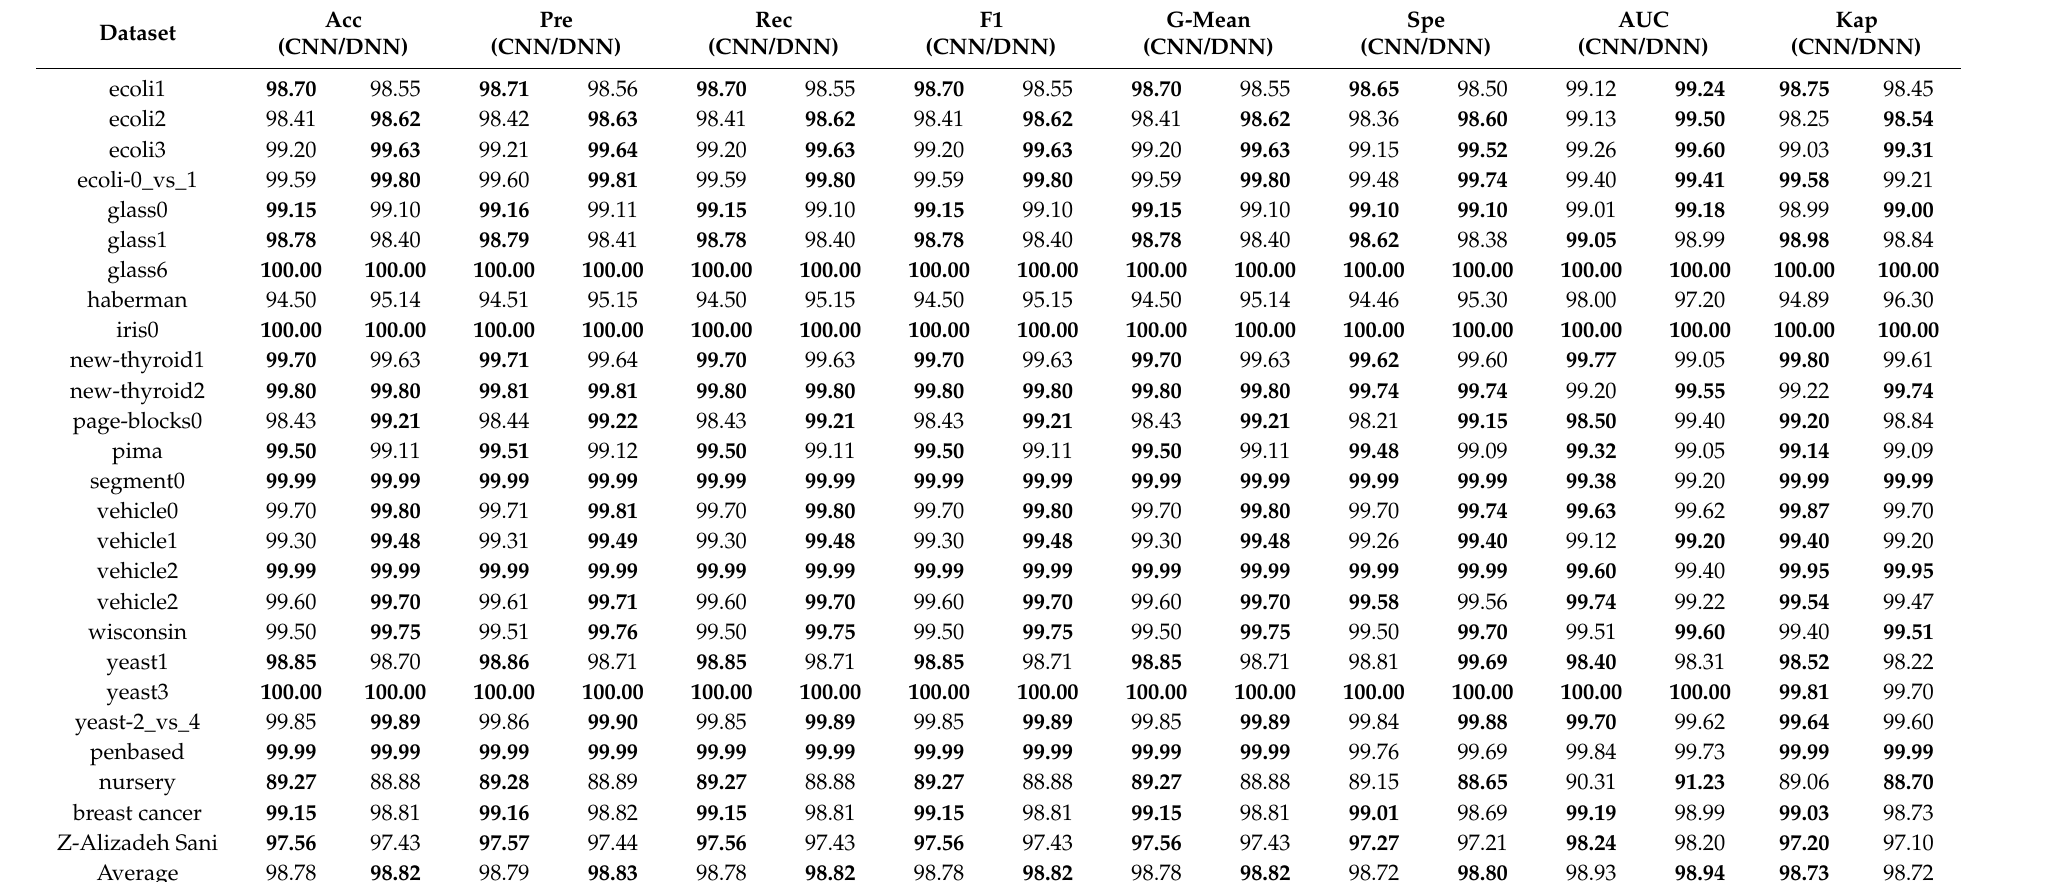
Table 8. OSS + NORM. +